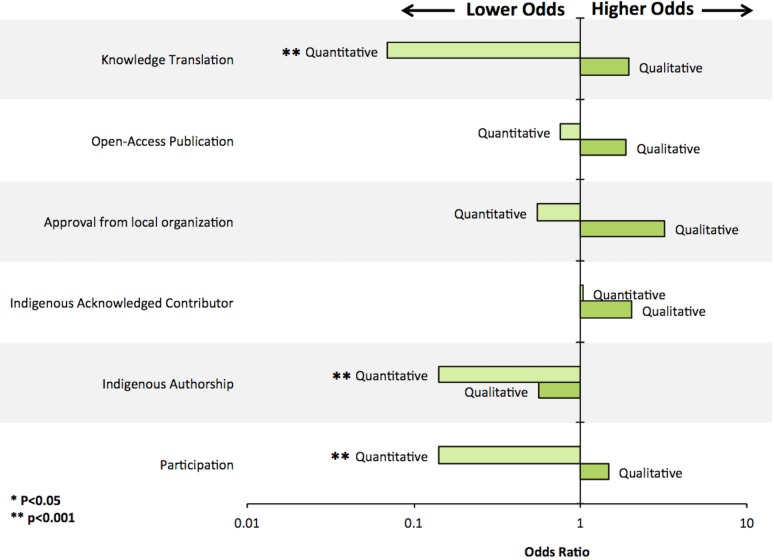
Multivariable exact logistic regression examining associations between research method and various indicators of community-engaged research.